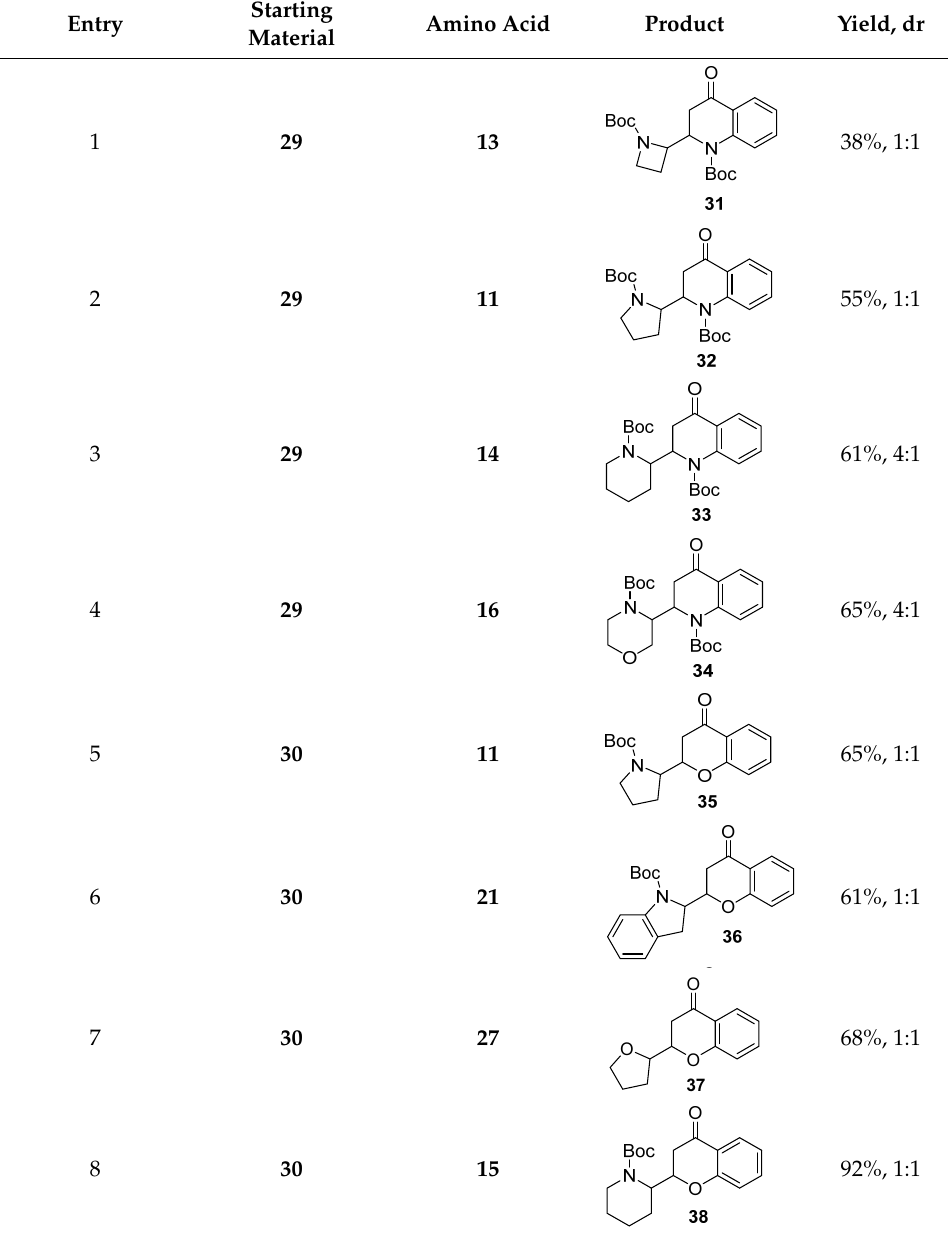
Table 2. Photocatalytic decarboxylative additions to 4-Oxoquinline 29 and chromenone 30 .